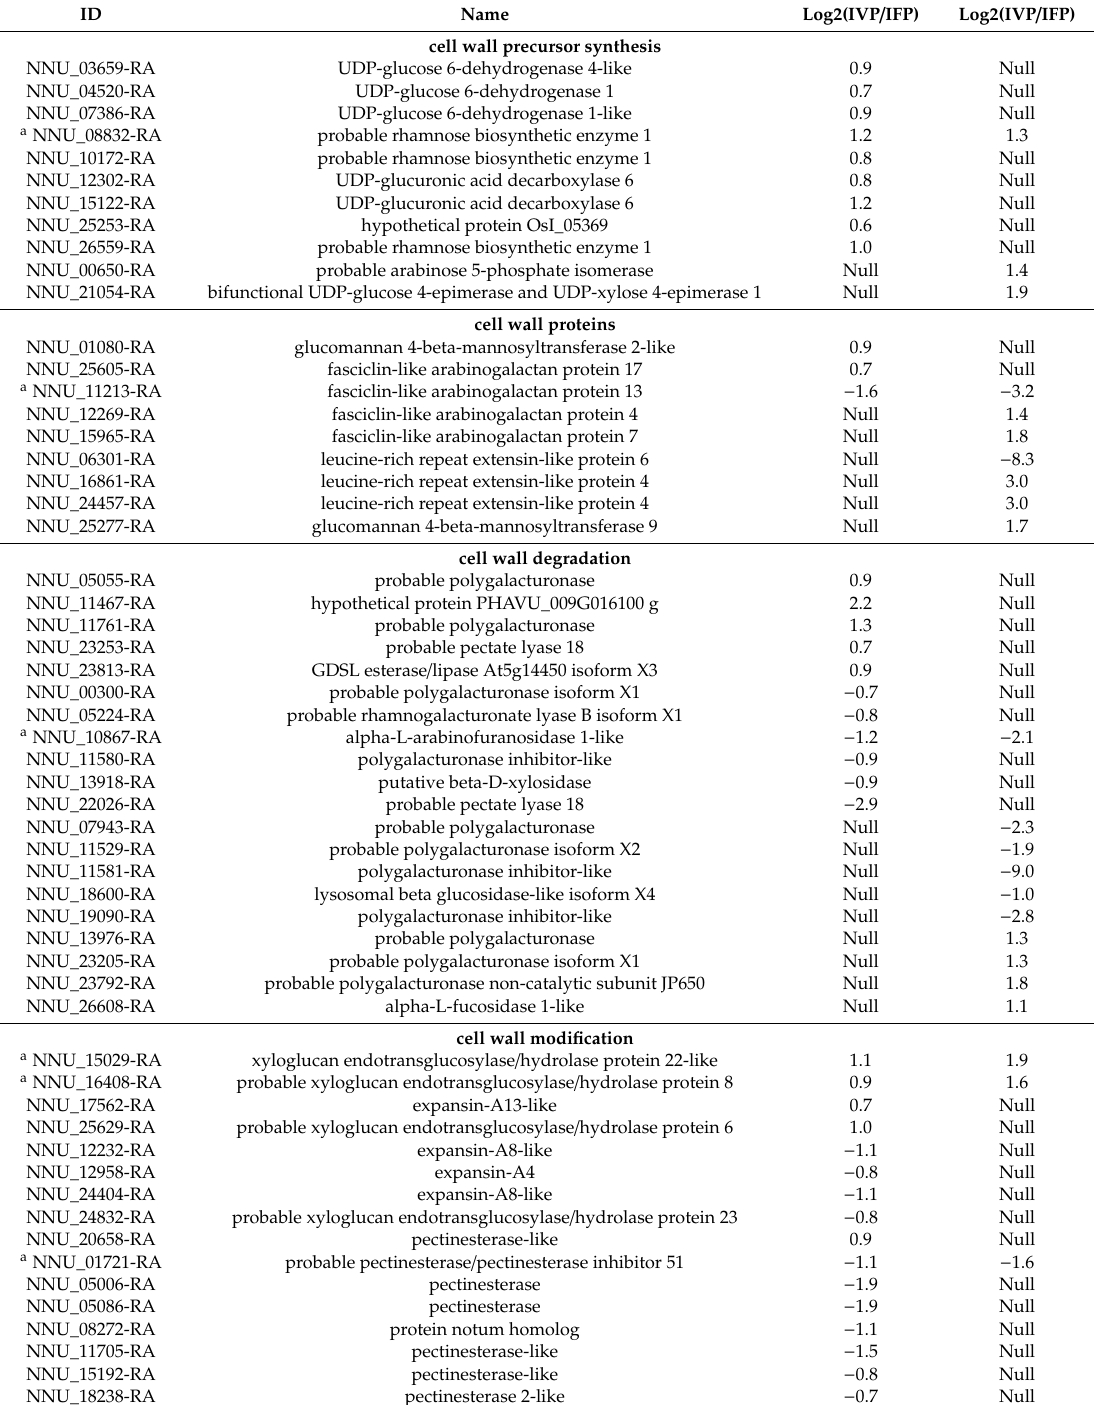
Table 1. DEPs and DEGs involved in cell wall